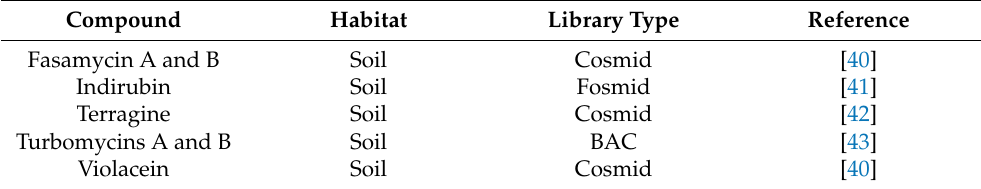
Table 1. Antibiotics discovered by function-based screening of metagenomic